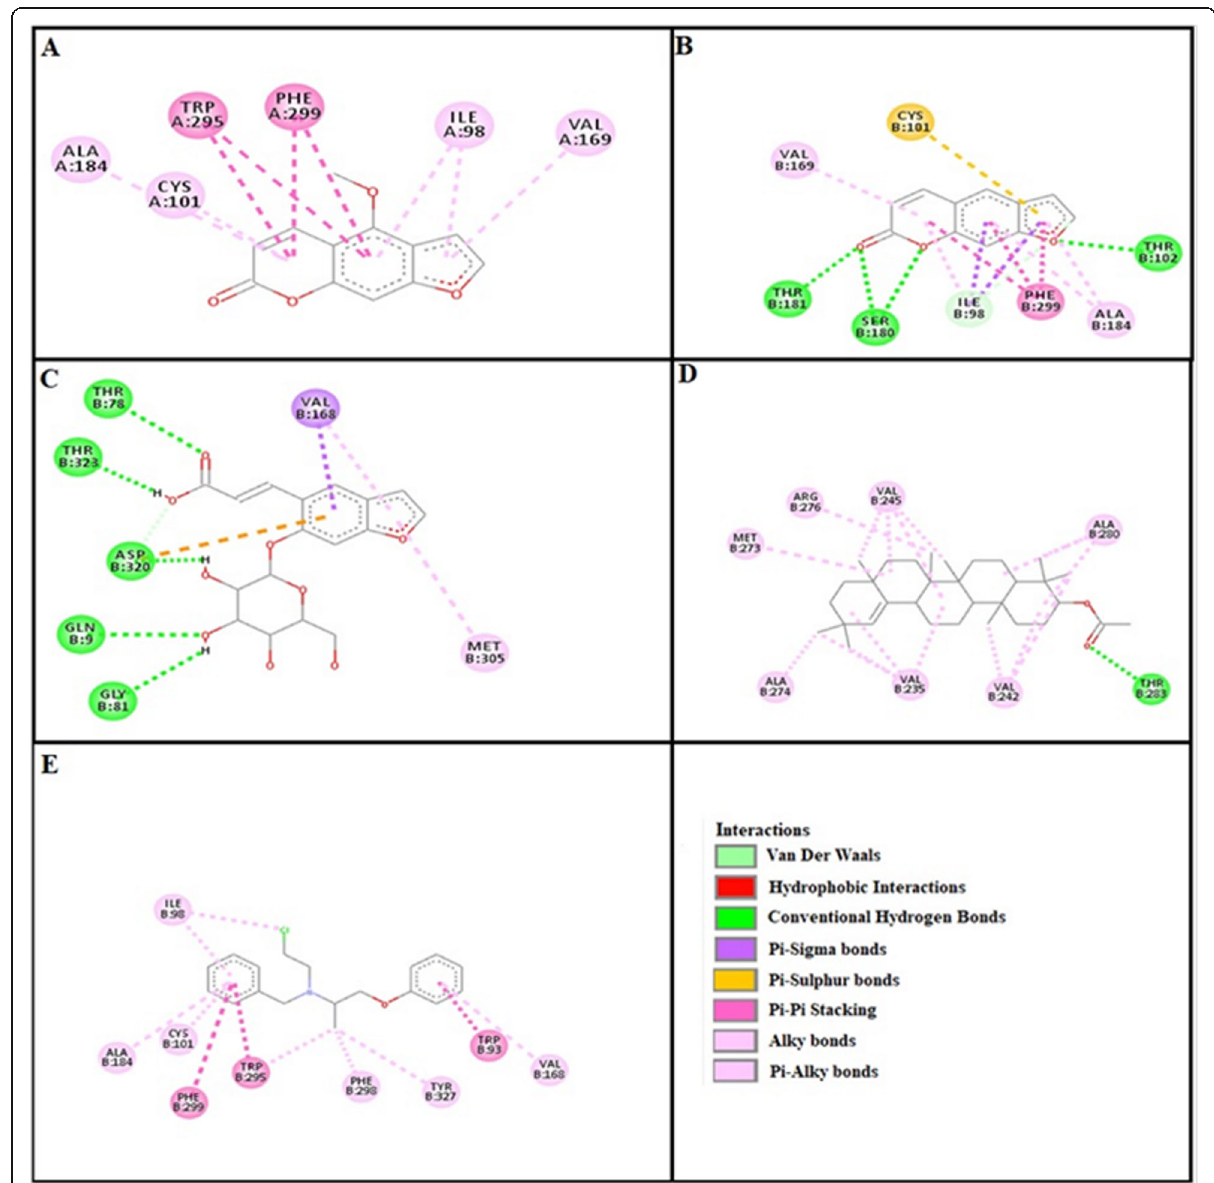
target: adrenergic α 1 receptor respectively, evaluated through Biovia Discovery Studio